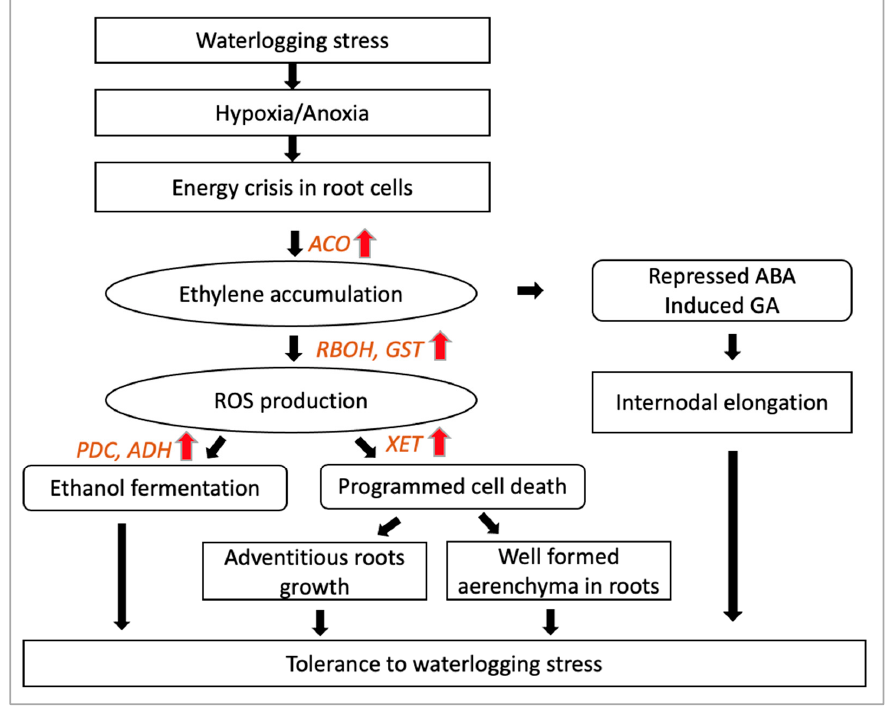
Figure 1. Schematic diagram of the main waterlogging stress responses and metabolic adaptive traits for waterlogging tolerance in plants. PDC: pyruvate decarboxylase, ADH: alcohol dehydrogenase, RBOH: respiratory burst oxidase homolog, GST: glutathione S transferase, XET: xyloglucan endo-transglycosylase, ACO: 1-amino-cyclopropane-1-carboxylic acid oxidase.